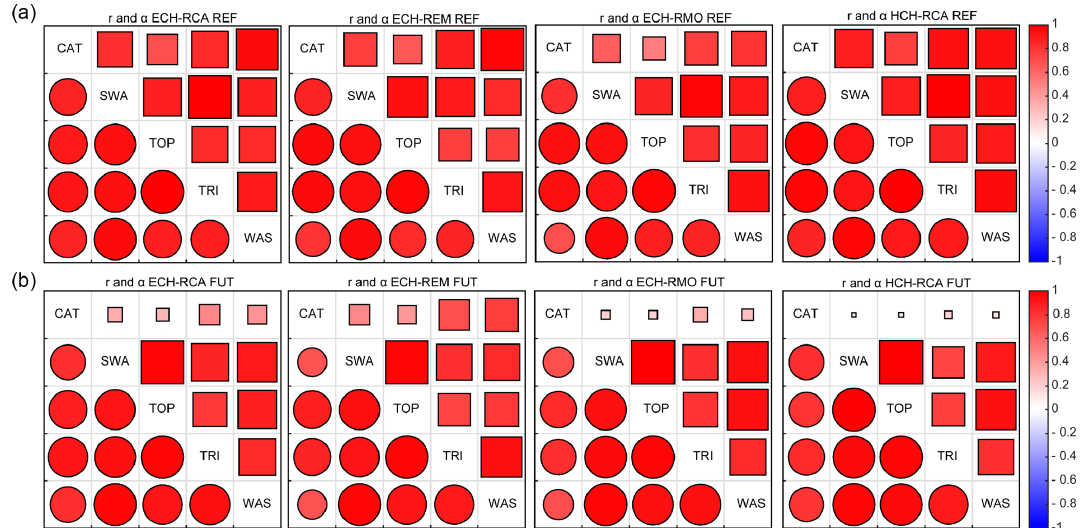
Figure 10. As Fig. 5, but for mean monthly discharge agreement between the five hydrologic models (CAT: CATHY, SWA: SWAT, TOP: TOPKAPI, TRI: tRIBS, WAS: WASIM). Each panel displays the agreement under a specific GCM–RCM forcing, for the reference (REF, a ) and future (FUT, b ) periods.